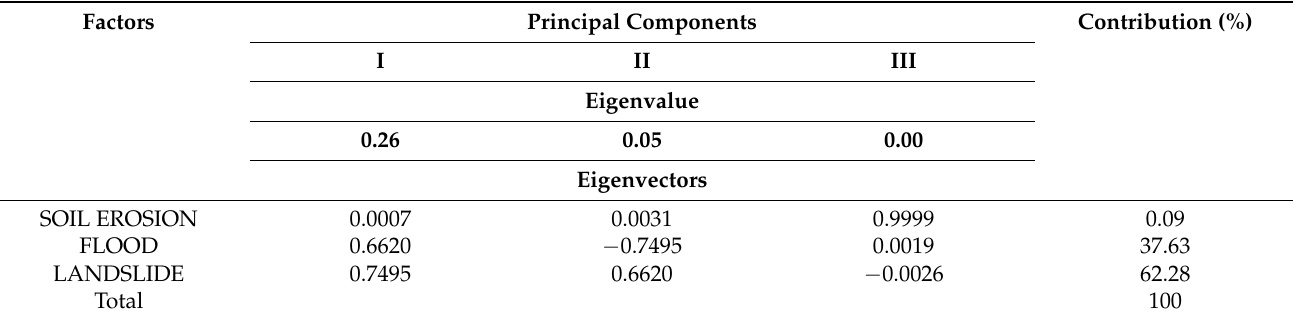
Figure 5. VED spatial distribution ( left ) and area statistics of the five vulnerability levels ( right ) from 2000 to 2015. The histogram represents the area of each level, and the line chart represents the percentage area of each level. Table 3. The different index contributions of